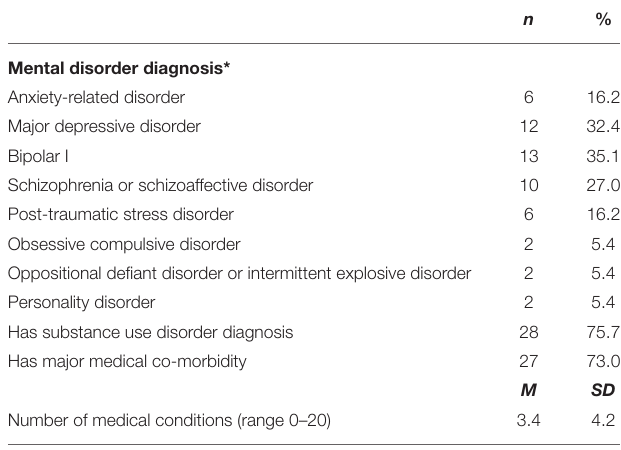
TABLE 1 | Mental health and medical